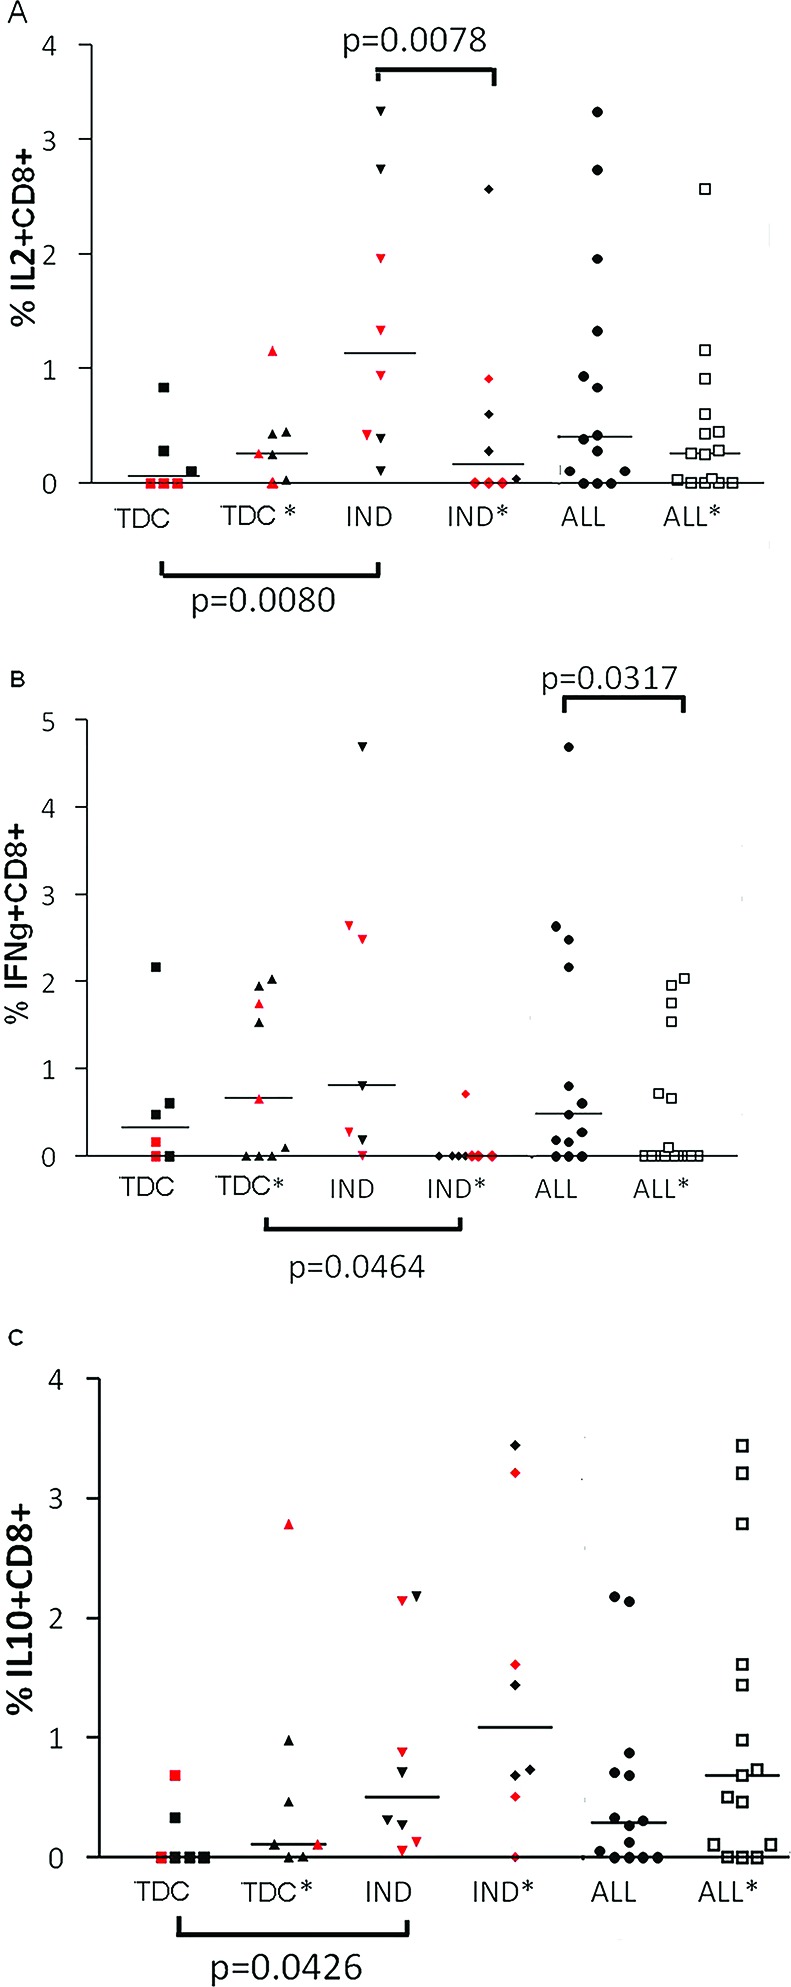
Proportion of cytokine-producing CD8+ T cells in chagasic sub-groups. (A) IL-2+CD8+. (B) IFN-γ+CD8+. (C) IL-10+CD8+. Patients were subdivided into a typical digestive and/or cardiac manifestation (TDC) sub-group and a non-cardiac/non-digestive manifestation of CD (IND) sub-group, and all chagasic (TDC and IND) patients were identified as the ALL group. The asterisk (*) represents the condition in which cells were stimulated with soluble T. cruzi antigen. The TDC and IND sub-groups had four HIV-infected individuals each. Red plots indicate HIV-infected individuals. The Mann-Whitney test was used for between-group comparisons (p indicated below the x-axis), and the Wilcoxon test was used for within-group comparisons (p indicated above the x-axis). The difference between TDC* and IND* stimulated T cells to produce cytokines was significant for the IFN-γ+CD8+ phenotype (Mann-Whitney test p=0.0464). The potential capability of T cells to produce cytokines was different between TDC and IND for the IL-2+CD8+ phenotype (Mann-Whitney test, p=0.0080) and the IL-10+CD8+ phenotype (Mann-Whitney test, p=0.0426). No significant differences were found in relation to the other phenotypes.